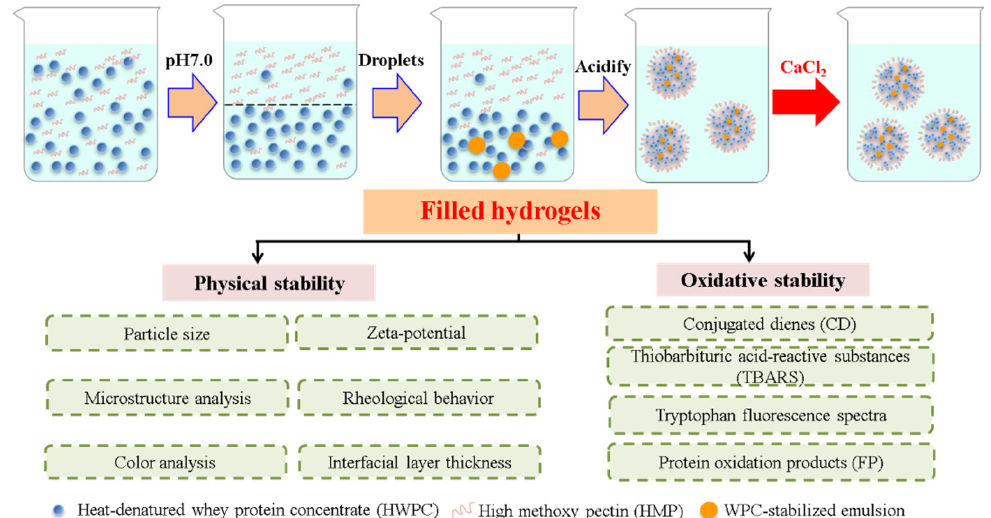
Figure 1. Schematic diagram of prepared filled hydrogels with different calcium chloride (CaCl 2 )